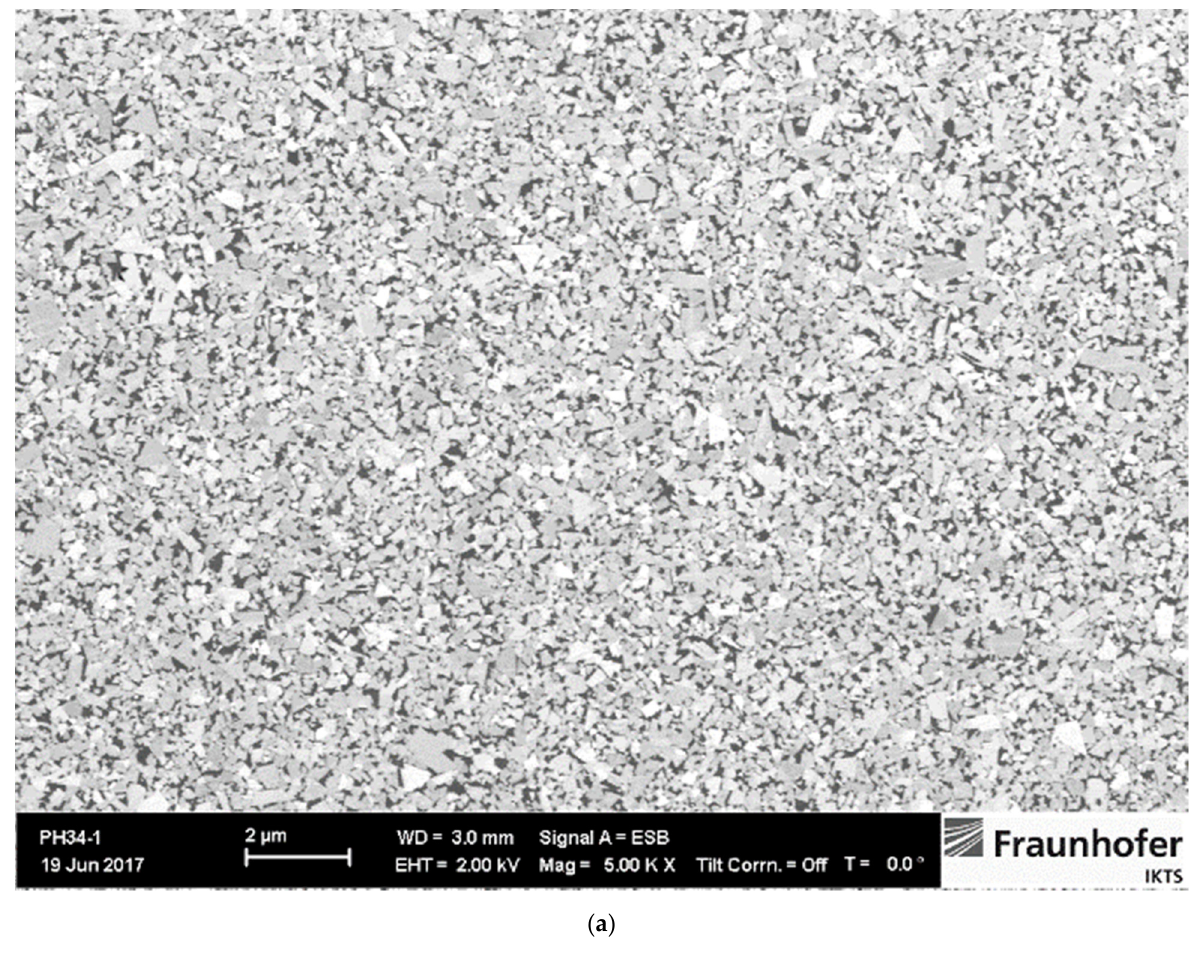
Figure 2. Microstructure and XRD pattern of WC-10Co sample [21]: ( a ) SEM image of microstructure; ( b ) XRD pattern.